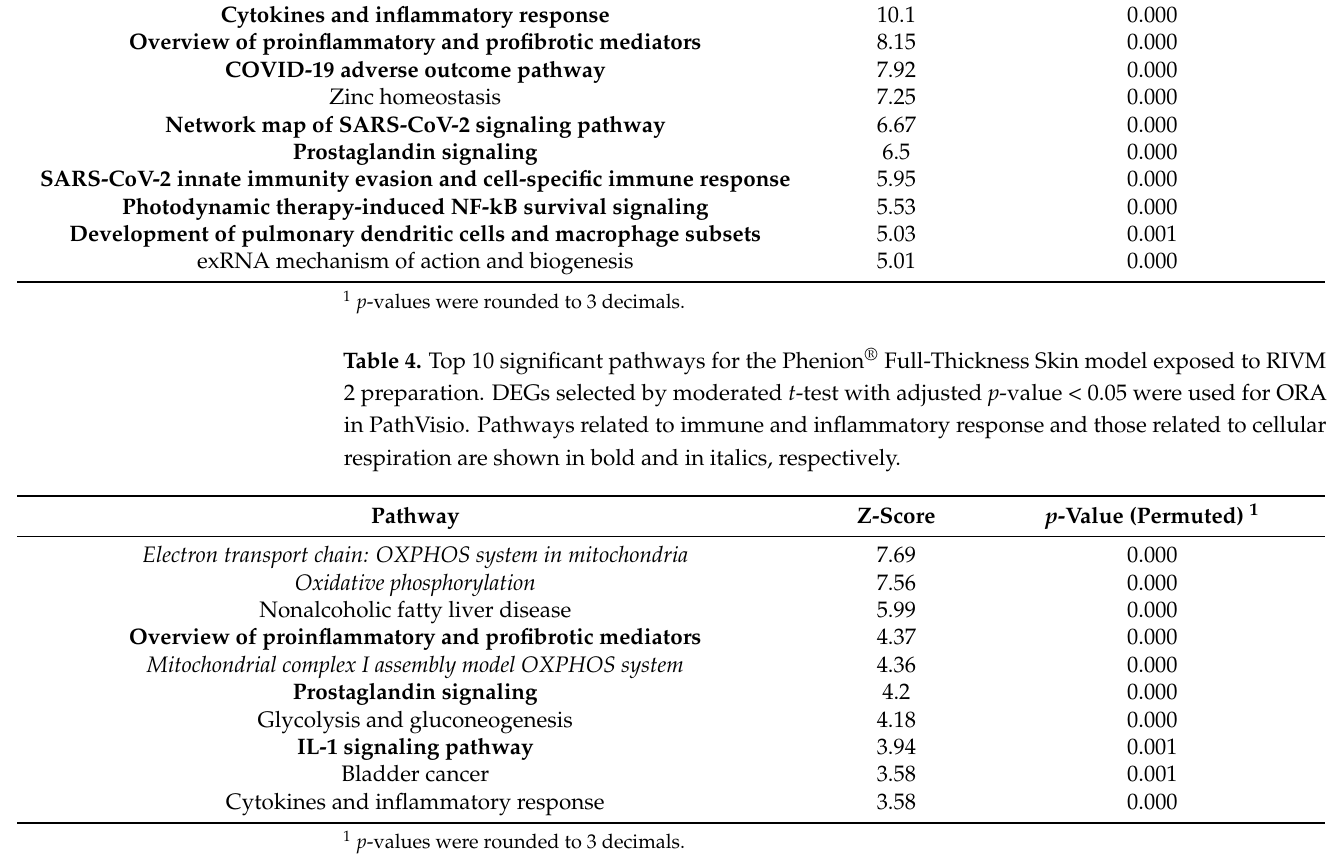
Table 5. Top 5 significant pathways for the Phenion ® Full-Thickness Skin model exposed to RIVM 1, 3, and 5 HA preparations. DEGs selected by moderated t -test with adjusted p -value < 0.2 were used for ORA in PathVisio. Pathways related to immune and inflammatory response are shown in bold. Pathway Z-Score p -Value (Permuted) 1 RIVM 1